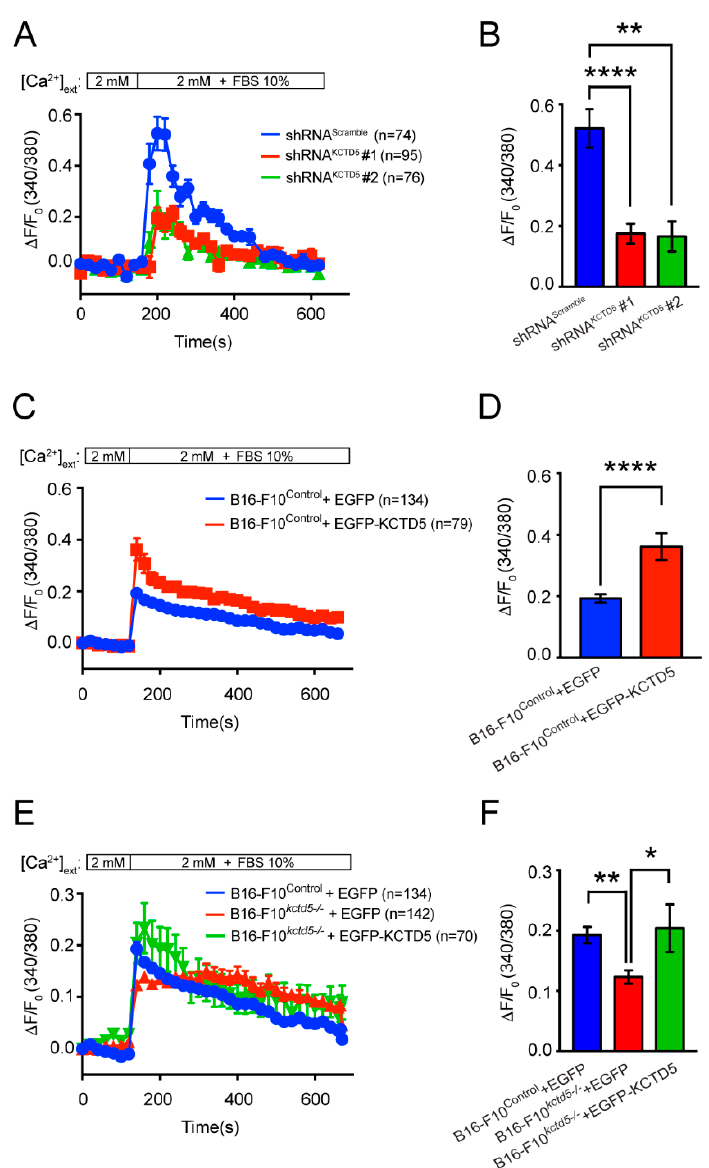
Figure 5. KCTD5 promotes serum-induced Ca 2 + signals in B16-F10 cells. ( A ) Time courses for normalized fluorescence in B16-F10 cells transfected with shRNA Scramble , shRNA KCTD5 #1 or shRNA KCTD5 #2 encoding plasmids. Cells were loaded with 5 µ M Fura-2-AM probe and Ca 2 + peak was induced by 10% v / v FBS in 2.5 mM CaCl 2 Krebs medium. Each point corresponds to the mean ± SEM. ( B ) Graph representing the mean ± SEM of ∆ F maximum / F 0 for each condition ( n = 7; One-way ANOVA followed by Tukey’s multiple comparisons test, ** p < 0.01, **** p < 0.0001). ( C ) Time courses for normalized fluorescence in B16-F10 Control cells transfected with EGFP or EGFP-KCTD5 encoding plasmids. Cells were loaded with 5 µ M Fura-2-AM probe and Ca 2 + peak was induced by 10% v / v FBS in 2 mM CaCl 2 Krebs medium. Each point corresponds to the mean ± SEM. ( D ) Graph representing the mean ± SEM of ∆ F maximum / F 0 for each condition ( n = 5; two-tailed unpaired Student’s t -test, **** p < 0.0001). ( E ) Time courses for normalized fluorescence in B16-F10 Control cells expressing EGFP and B16-F10 kctd5- / - cells expressing EGFP or EGFP-KCTD5 construct. Cells were loaded with 5 µ M Fura-2-AM probe and Ca 2 + peak was induced by 10% v / v FBS in 2 mM CaCl 2 Krebs medium. Each point corresponds to the mean ± SEM. ( F ) Graph representing the mean ± SEM of ∆ F maximum / F 0 for each condition ( n = 5; One-way ANOVA followed by Tukey’s multiple comparisons test, * p < 0.05, ** p < 0.01).